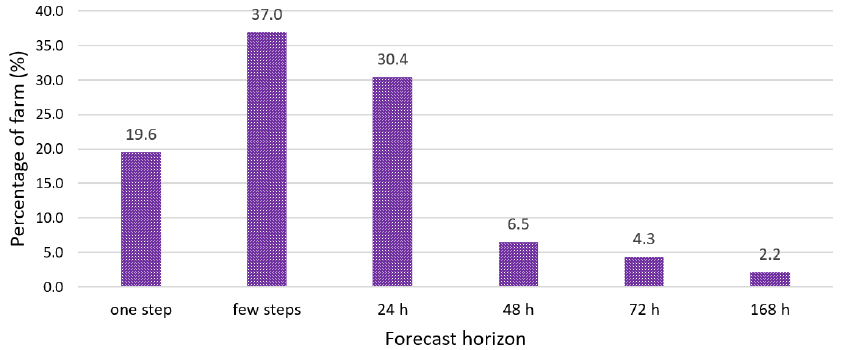
Figure 6. Frequency of forecasts from different forecasting horizons.